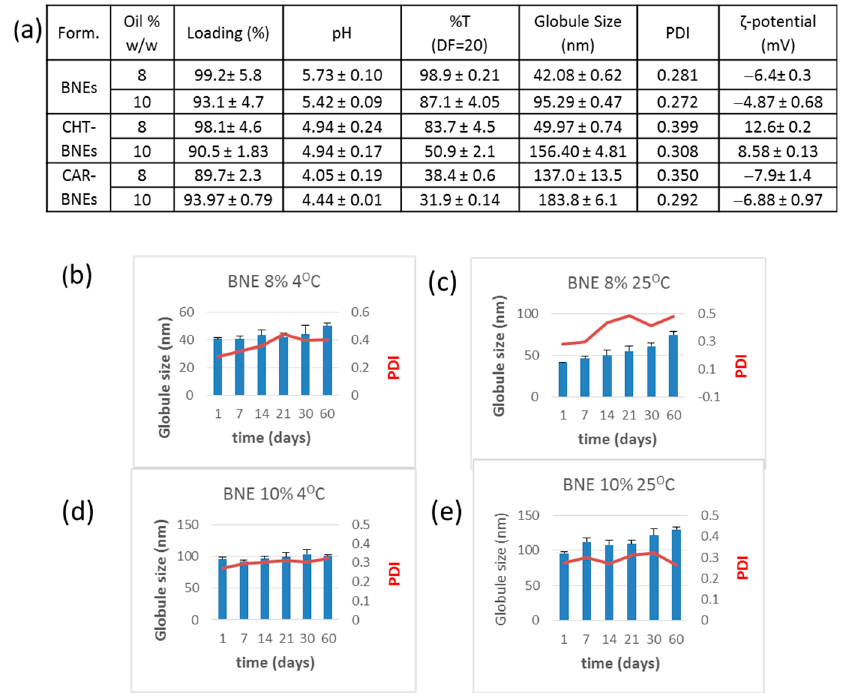
Figure 5. ( a ) Physicochemical properties of the BNN27-loaded NEs (BNEs) composed of Tween 80 (as the surfactant) and oil content of 8% or 10%. Some BNEs were coated with CHT (CHT-BNEs) or Carbopol (CAR-BNEs). ( b , c ) Stability of BNE with the 8% oil-phase during 60 days of storage at 4 °C and 25 °C, respectively. ( d , e ) Stability of BNE with the 10% oil-phase during 60 days of storage at 4 °C and 25 °C, respectively.